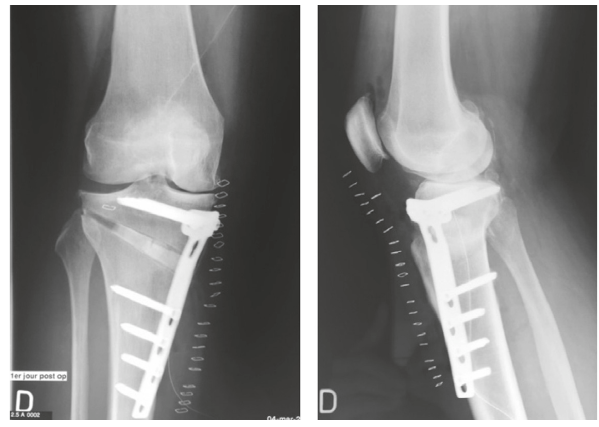
Figure 4: Early June 2010, 1 year after HTO, postoperative X-rays showing an important pullout of the proximal screws and slight translation of the proximal fragment of the